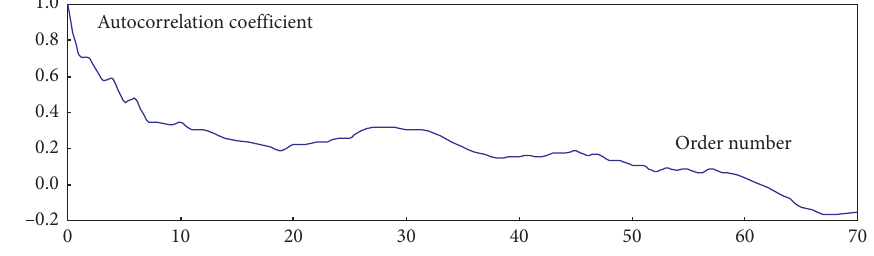
Figure 5: Autocorrelation coefficient of the residual sequence.